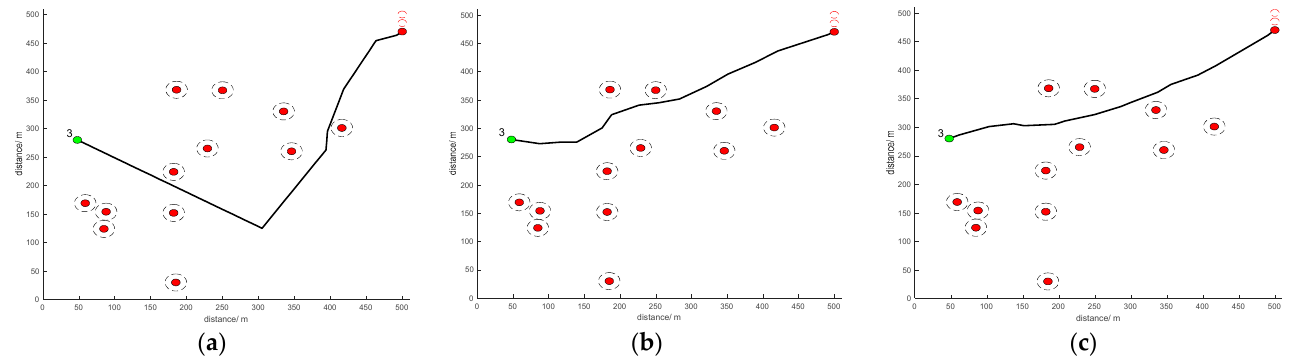
Figure 9. The path results of each algorithm for vehicle No. 1 with 5 vehicles in MUVs. ( a ) is the path result of RRT-connect; ( b ) is the path result of RRT*; ( c ) is the path result of dual RRT optimization.